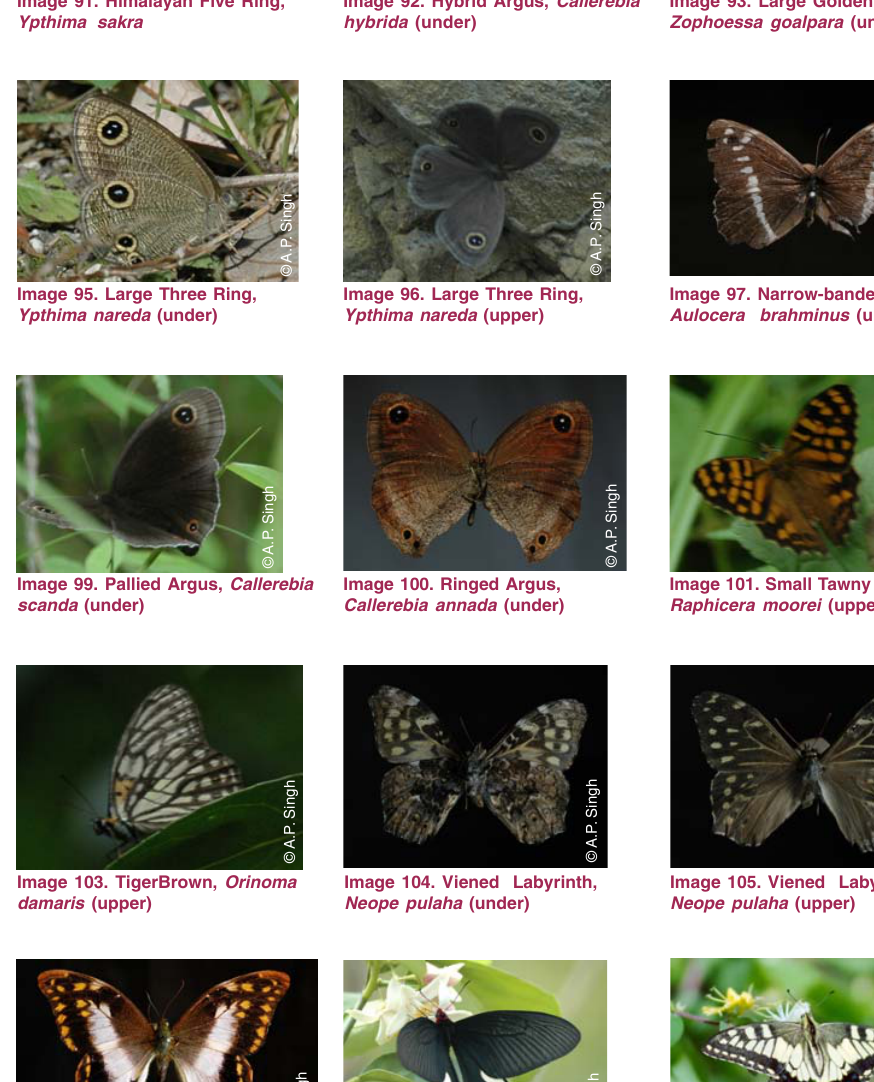
Image 107. Brown Gorgon, Meandrusa lachinus female